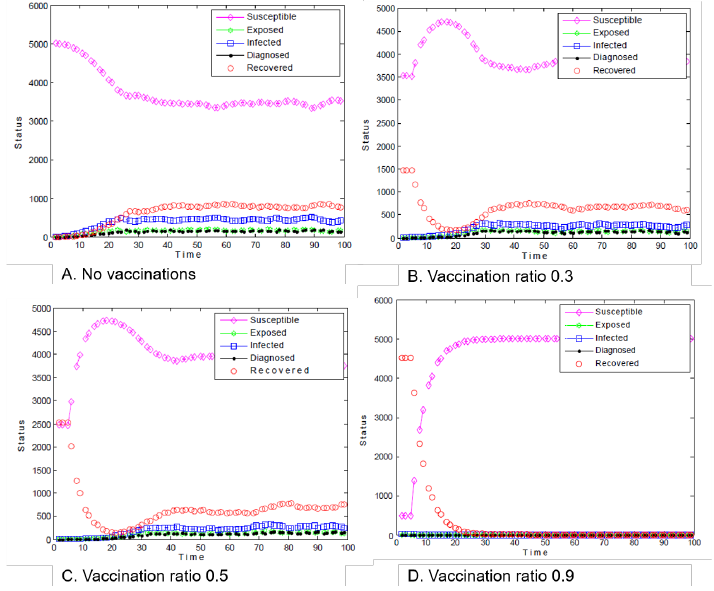
Fig. 1 The impact of mental health education penetration rate on the dissemination of wrong information.